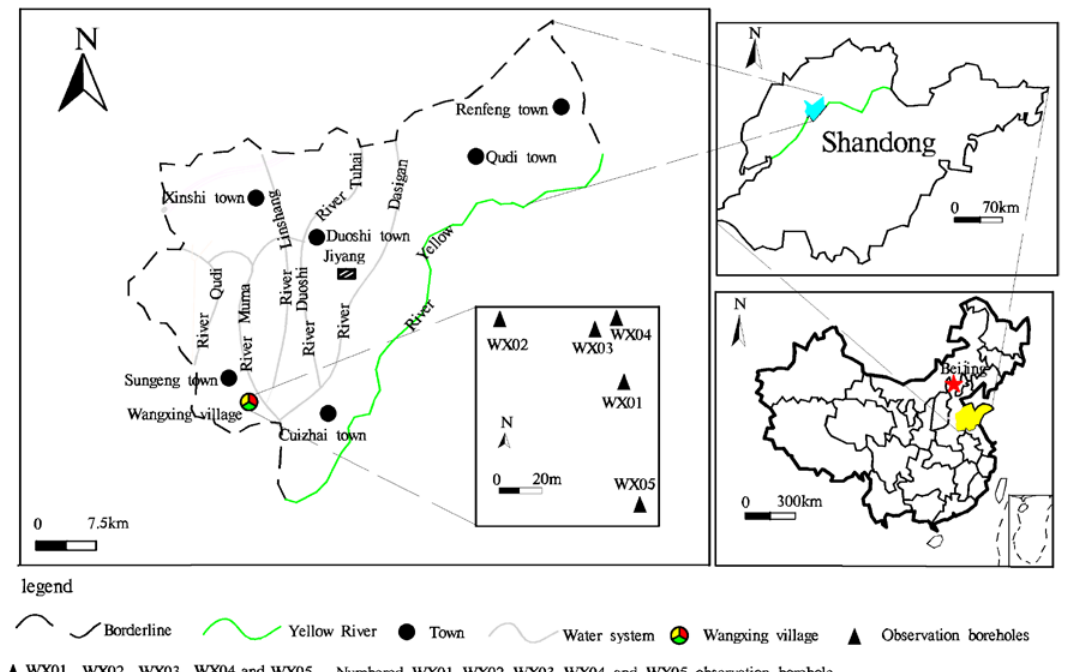
Figure 1. Location of the study area.